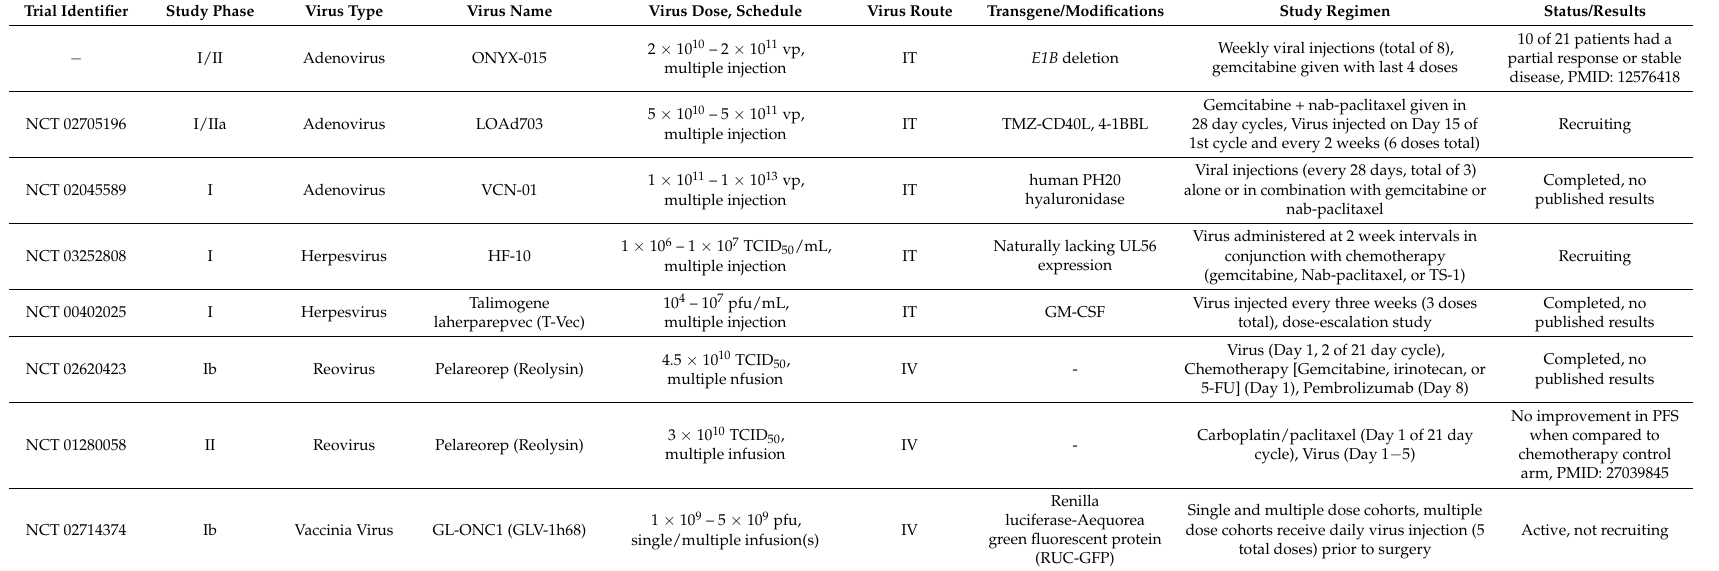
Table 2. Key oncolytic virotherapy clinical trials in pancreatic